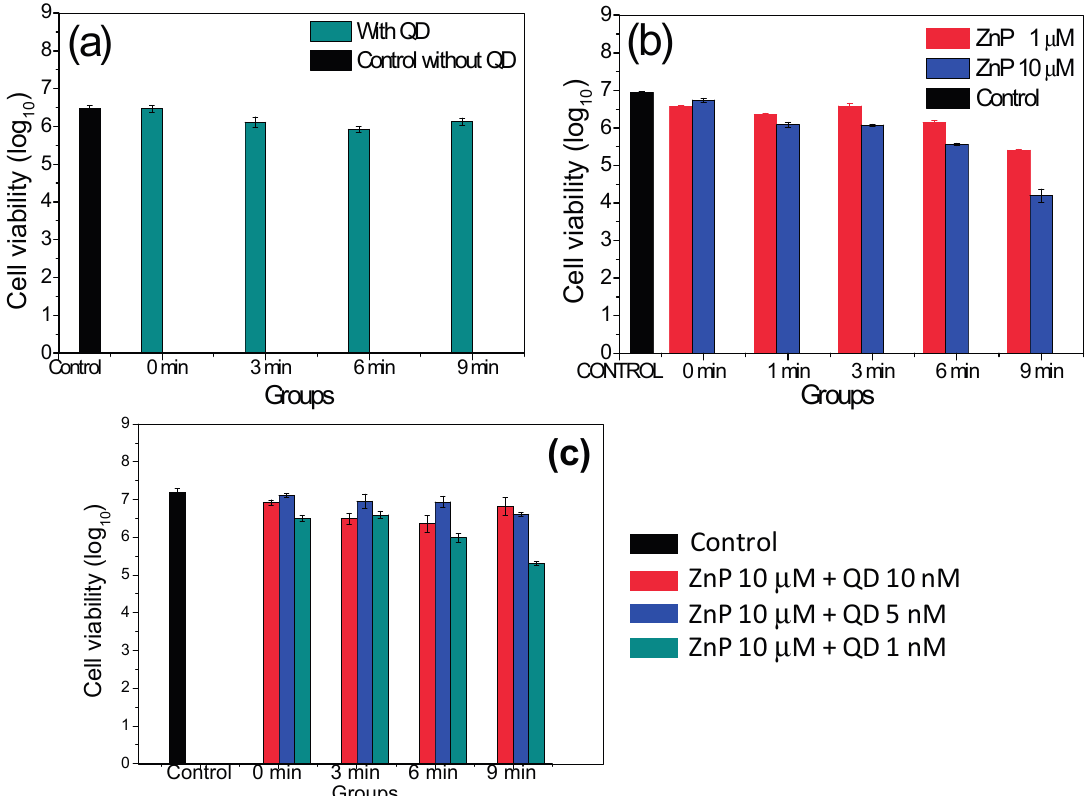
Figure 7. Evaluation of photodynamic inactivation of a culture of Candida albicans ATCC 10231. ( a ) Cell viability after addition of 20 µL of CdTe-MSA QD 10 nmol·L − 1 , under different irradiation doses with LED 460 nm (±20 nm). Between the control group and the non-irradiated QD group (0 min) there is no significant difference; there is a significant difference between the irradiated groups compared to the control group with p value < 0.01; ( b ) Cell viability after addition of 20 µL of ZnP 1 and 10 µmol·L − 1 , under different irradiation doses with LED 460 nm (±20 nm); there are statistically significant differences between all groups evaluated, with greater evidence for ZnP (10 µM) groups at times 6 and 9 min irradiation and ZnP (1 µM) in 9 min compared to the control group; ( c ) Cell viability after addition of 20 µL of different proportions of QDs-ZnP under different levels of irradiation. Control means non-irradiated cells. There are statistically significant differences between all groups evaluated, with greater evidence for QD-ZnP group (1 nM:10 µM and 9 min irradiation) compared to the control group. Control group (non-irradiated; incubation time = 9